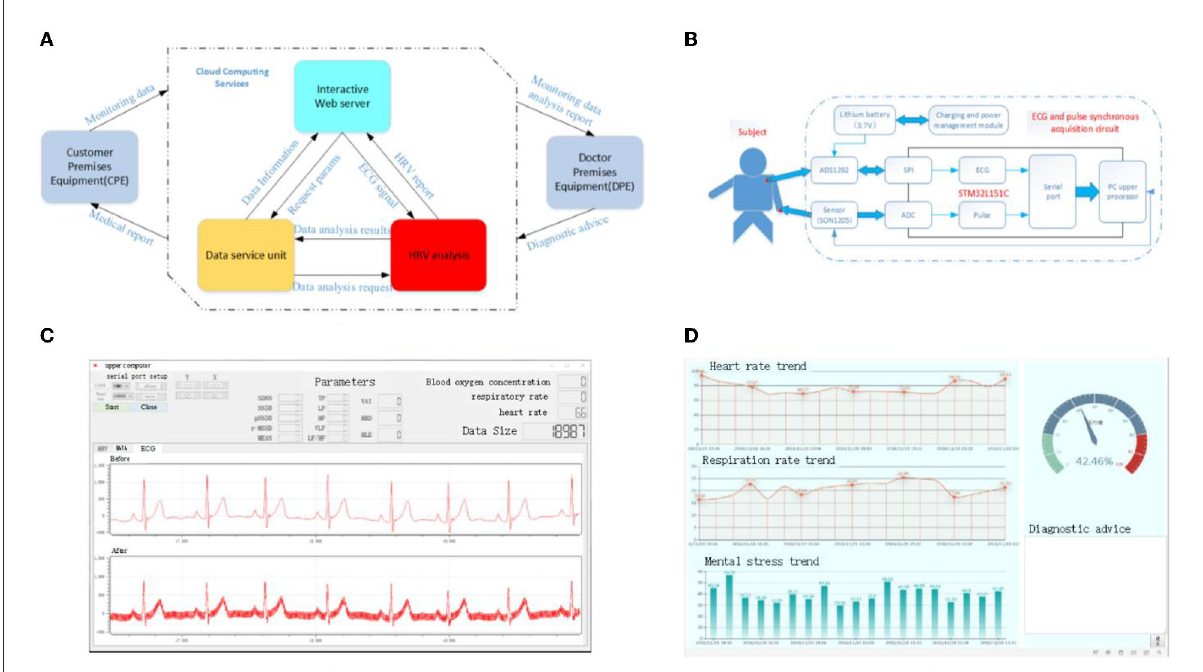
FIGURE7 Schematic representation of the experimental test platform for HRV. (A) Overall structure diagram of the server, (B) schematic diagram of the customer premises equipment, (C) data acquisition interface of upper computer, and (D) electronic medical record